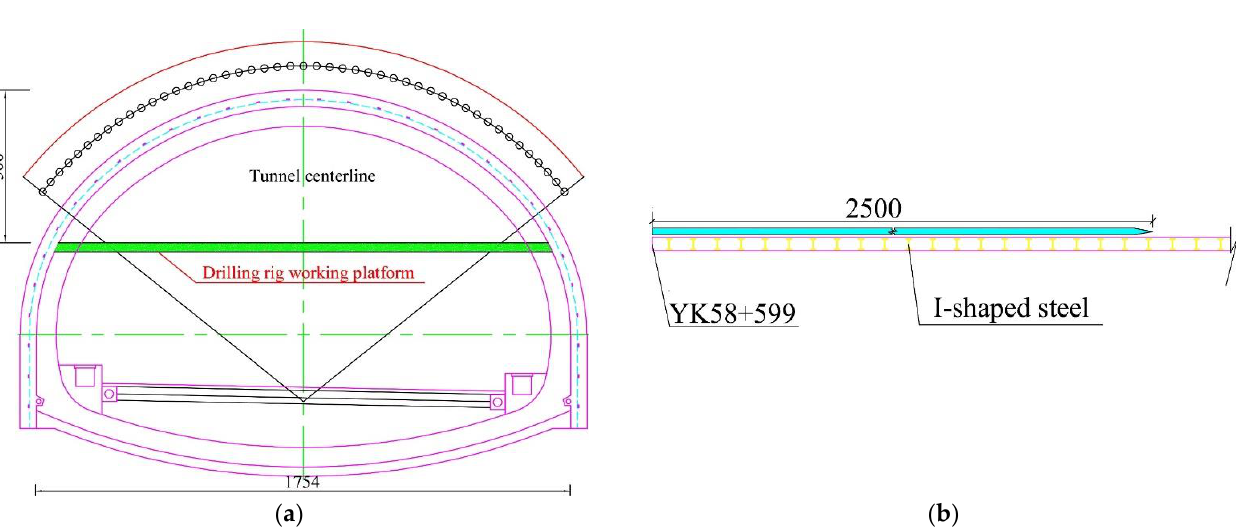
Figure 6. Schematic diagram of advance pipe shed support: ( a ) cross-section; ( b ) longitudinal section.